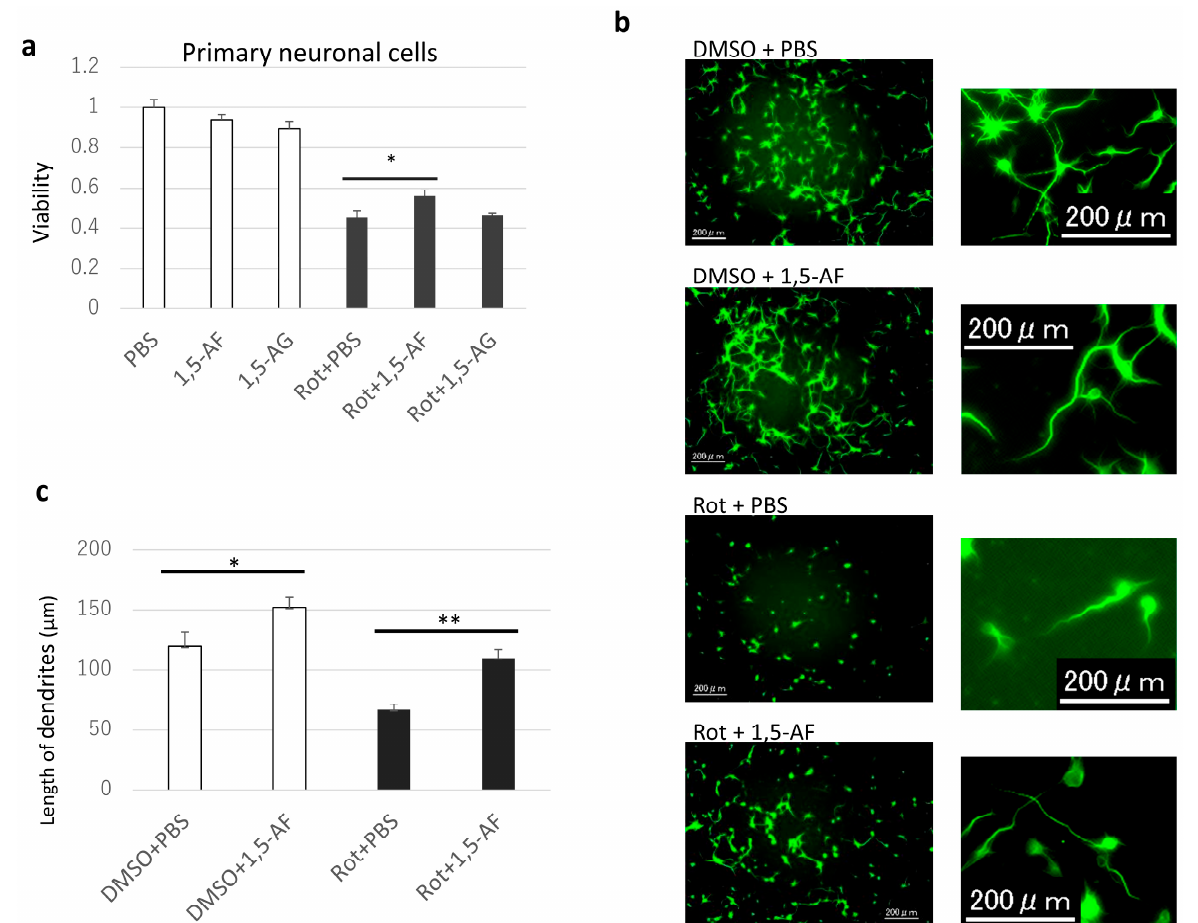
Figure 3. Protective effects of 1,5-AF against rotenone in primary neuronal cells. ( a ) Protective effects of 1,5-AF against rotenone-induced cytotoxicity in primary neuronal cells, evaluated using the MTT assay (one-way analysis of variance). ( b ) Representative confocal images of microtubule-associated protein 2 (MAP2) staining in primary neuronal cells (magnifi- cation: 20 × ; scale bars: 200 µ m). Panels in the right column are magnified versions of images in the left column. Rotenone affected cell shape, dendrite length, and cell number. ( c ) Quantification of the effects of 1,5-AF on dendritic length from confocal images of MAP2-stained primary neuronal cells. Rotenone affected dendritic length. All data are expressed as the mean ± standard error of the mean. * p < 0.05, ** p < 0.01. 1,5-AF, 1,5-anhydro-D-fructose; 1,5-AG, 1,5-anhydroglucitol; DMSO, dimethyl sulfoxide; PBS, phosphate-buffered saline; Rot, rotenone.